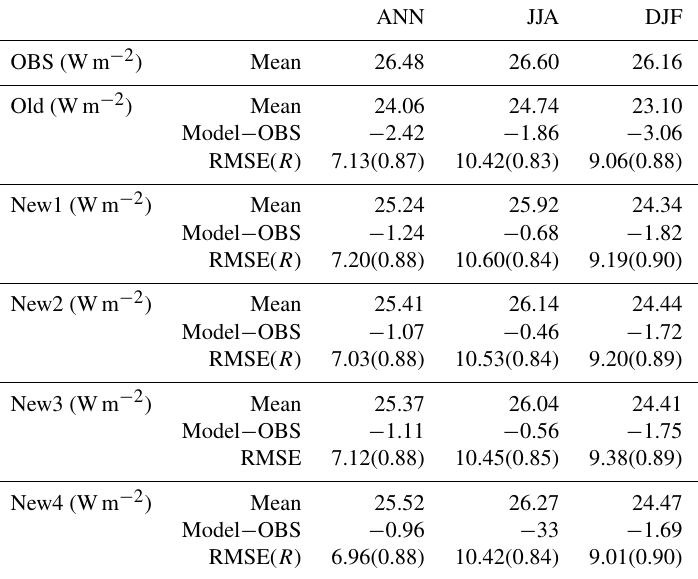
Table 4. Mean (annual and seasonal global mean values) and Model–OBS (the difference of annual and seasonal global mean values between models and observations), RMSE (root mean squared error), and R (spatial pattern correlation) of the modeling results compared to the observed LWCF from CERES-EBAF for ANN, JJA, and